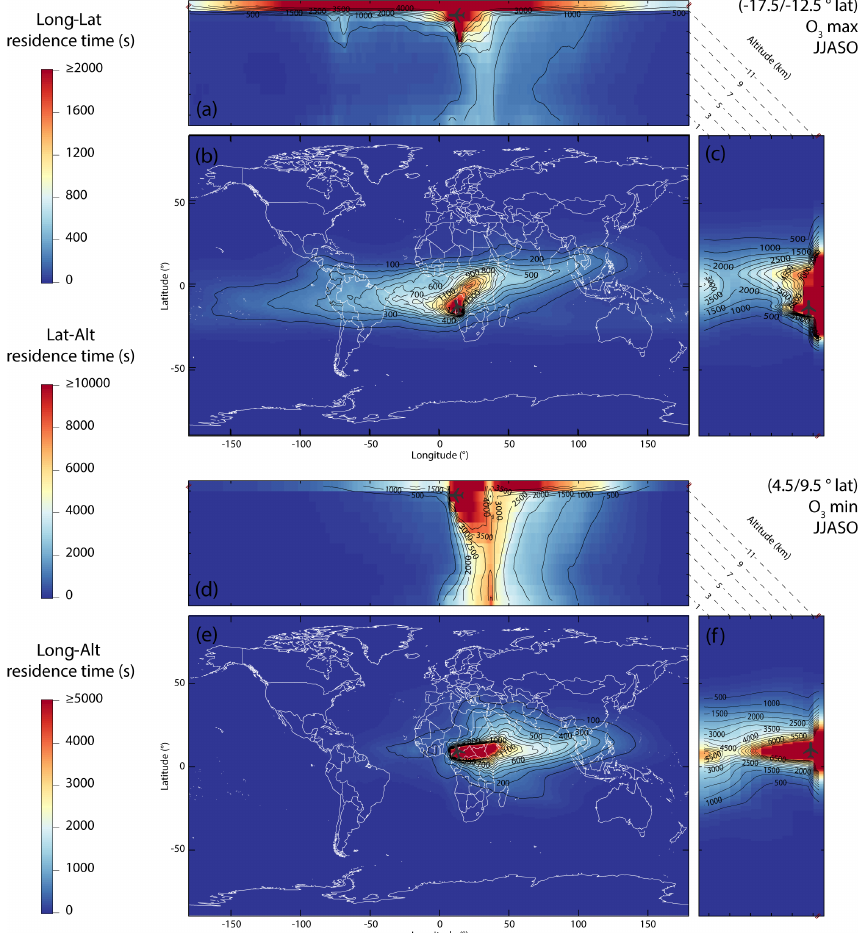
Figure 8. FLEXPART backward plume of air masses where IAGOS flights have recorded maxima (between 17.5 and 12.5 ◦ S: a, b, c ) and minima (between 4.5 and 9.5 ◦ N: d, e, f ) of ozone in JJASO. Plumes are represented in terms of the residence time of particles in each individual output box in seconds, summed on the 20d backward, on 5 ◦ lat of flight and on total column (latitude column for a, d , altitude column for b, e , and longitude column for c, f ), and averaged over all studied years. Note that the color scale is different for longitude–altitude profiles (a, d) , longitude–latitude maps (b, e) and latitude–altitude profiles (c, f)